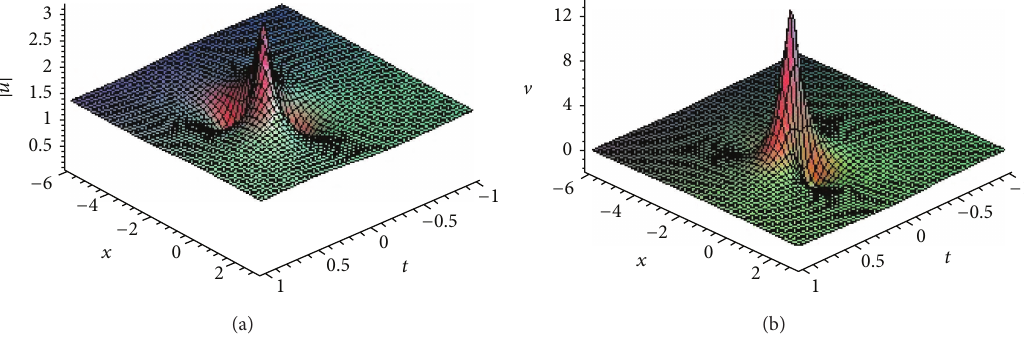
Figure 2: (a) Homoclinic rogue wave |𝑢 1 | in solution (13). (b) Homoclinic rogue wave V 1 in solution